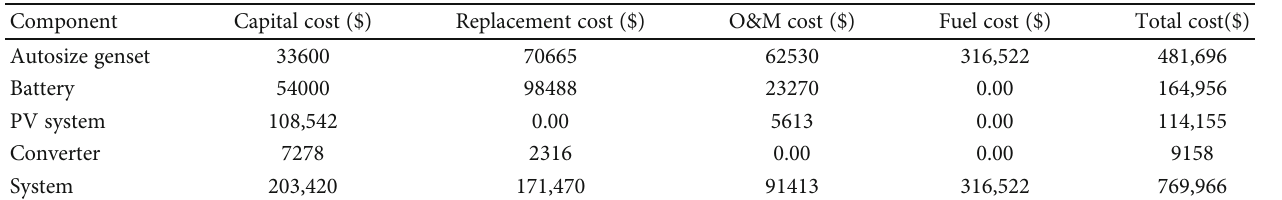
Table 6: Optimized cost summary of the solar-diesel-battery system for the tertiary scenario.